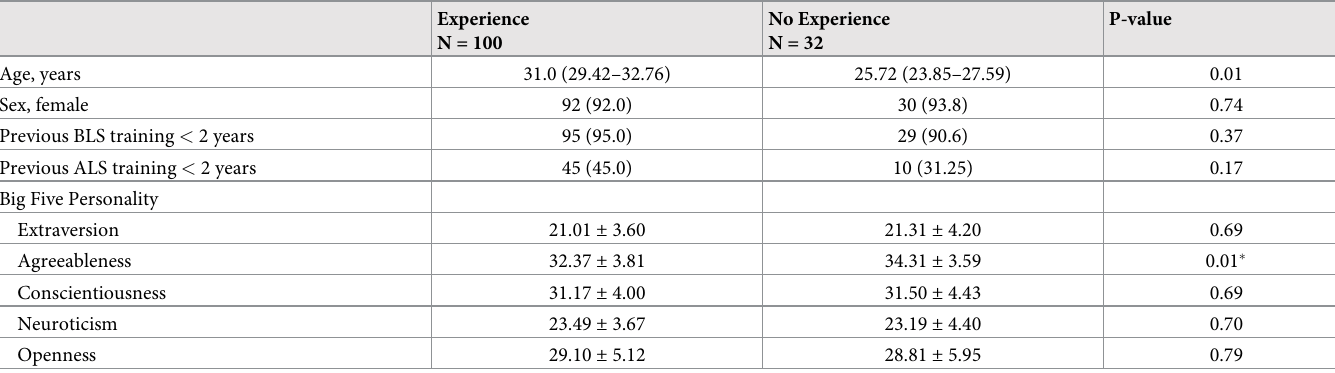
Table 4. Subgroup analysis according to the cardiac arrest